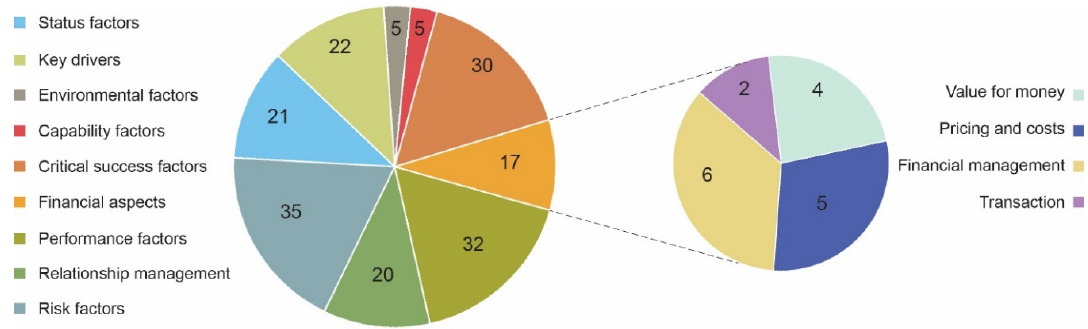
Figure 2. Distribution of important factors/dimensions addressed in PPP infrastructure publications. Source: selected literature.